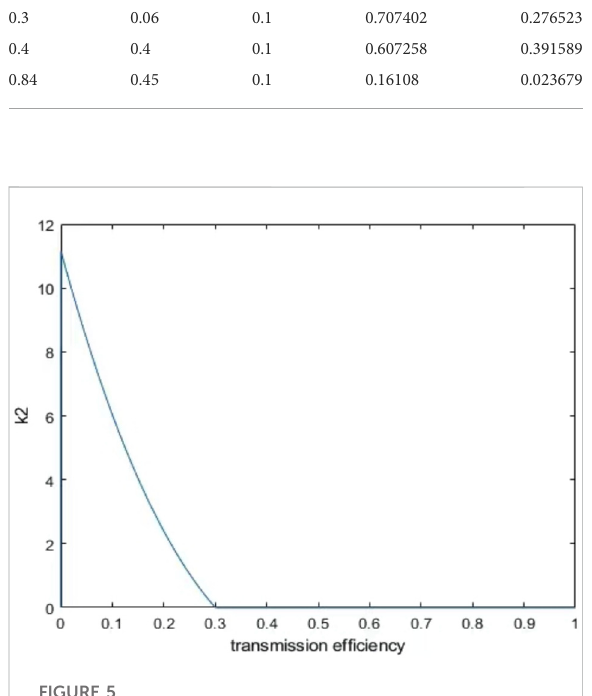
FIGURE 5 When μ = 0.03 and v = 0.01, the relation image between K 2 and ŋ isobtained accordingtoEq.25.Wecanseethatthestronger the loss in the channel, the higher the value of K 2 (the probability that Eve can block a single photon), which is the same as in Figure 4. We can also see that the second method requires more